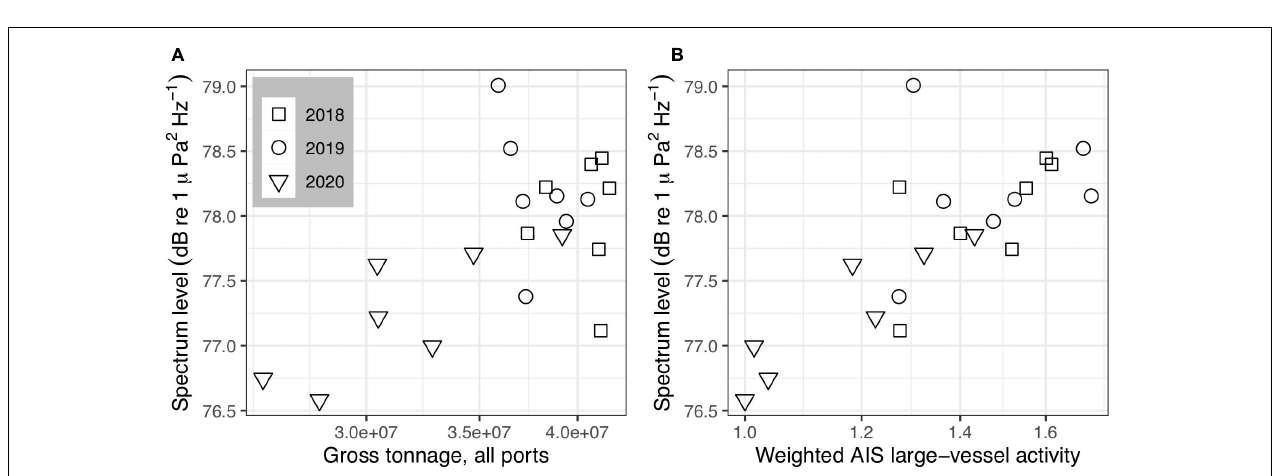
FIGURE 9 | Relationships between metrics of regional large-vessel activity and low-frequency noise at MARS. The low-frequency noise metric is the monthly geometric mean spectrum level for the 63 Hz one-third octave band ( Figure 6 ); both vessel activity metrics are plotted on a logarithmic scale. Metrics of regional large-vessel activity are (A) monthly sums of gross tonnage for California ports ( Figure 7 ), and (B) monthly sums of vessel presence derived from AIS records that were weighted according to modeled acoustic transmission loss ( Figure 8 ) and vessel speed. Monthly sums in (B) are normalized to the minimum to facilitate interpretation. The maximum is ∼ 72% greater than the